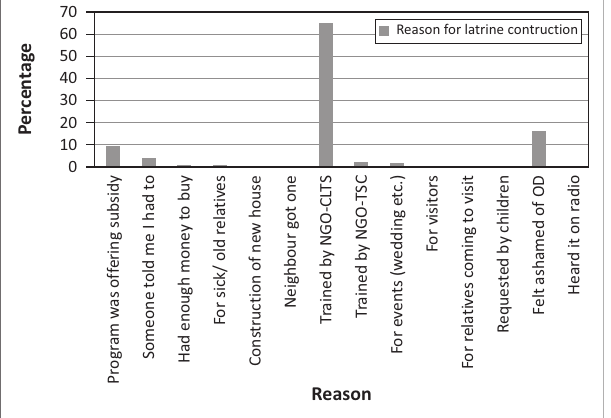
FIGURE 9: Reason for latrine construction.